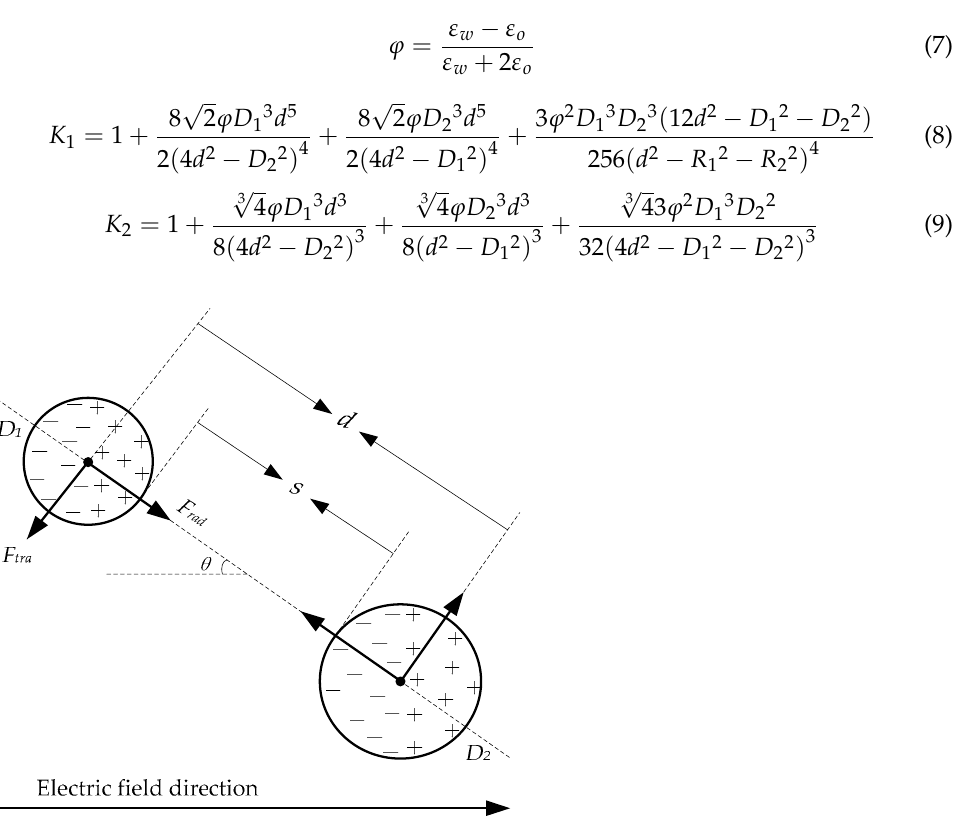
where d indicates the distance between the centers of the two droplets, m, and θ is the angle between the electric field line and the center connection of the two droplets. The Clausius–Mossotti ( ϕ ) and the constant coefficient s( K 1 ), ( K 2 ) are expressed as follows: